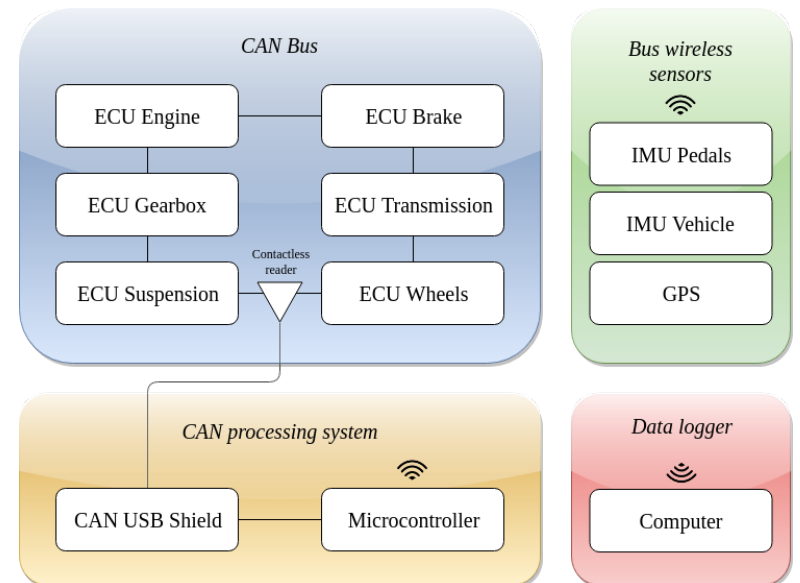
Figure 2. Diagram of the connections between the different data sources and the data logger. The external sensors communicate directly with the computer and the internal vehicle data are available from the CAN bus network employing a contactless reader. This data are then processed by a microcontroller and sent to the data